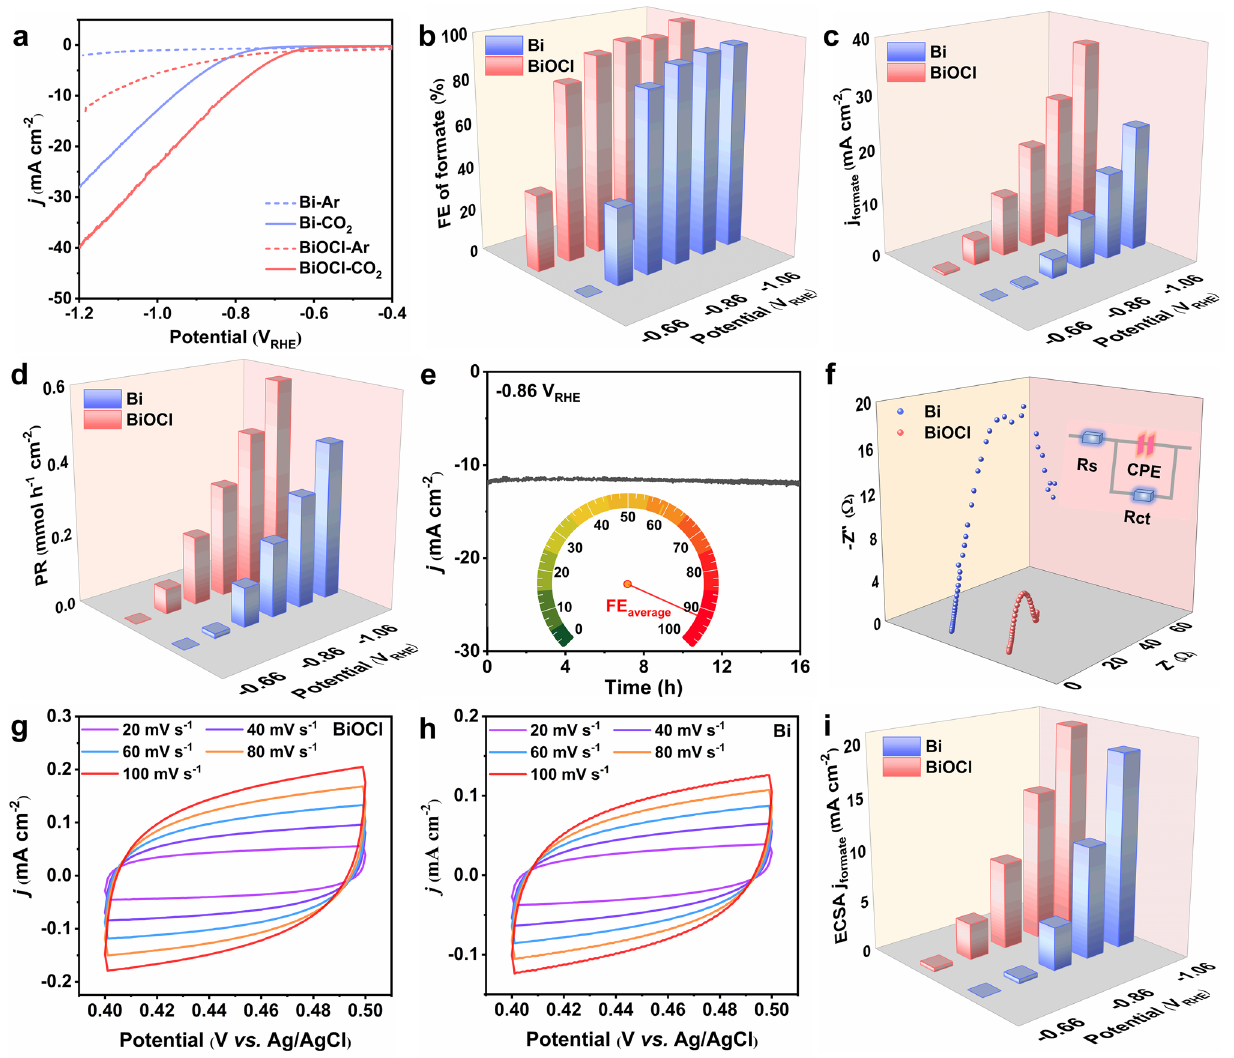
Fig. 2 Electrochemical performance of Bi-based catalysts for cathodic CO 2 RR in H-cell. a LSV curves of BiOCl and commercial Bi powder in Ar- or CO 2 -saturated 0.5 M KHCO 3 . b Formate FE, c formate partial current density and d formate production rate (PR) of BiOCl and commer- cial Bi powder at different potentials. e Long-term stability test of BiOCl at − 0.86 V RHE for 16 h. f Nyquist plots of BiOCl and commercial Bi powder at − 0.76 V RHE (inset is the corresponding equivalent circuit diagram). CV curve of g BiOCl nanosheet and h commercial Bi powder at different scan rates. i ECSA-corrected formate partial current